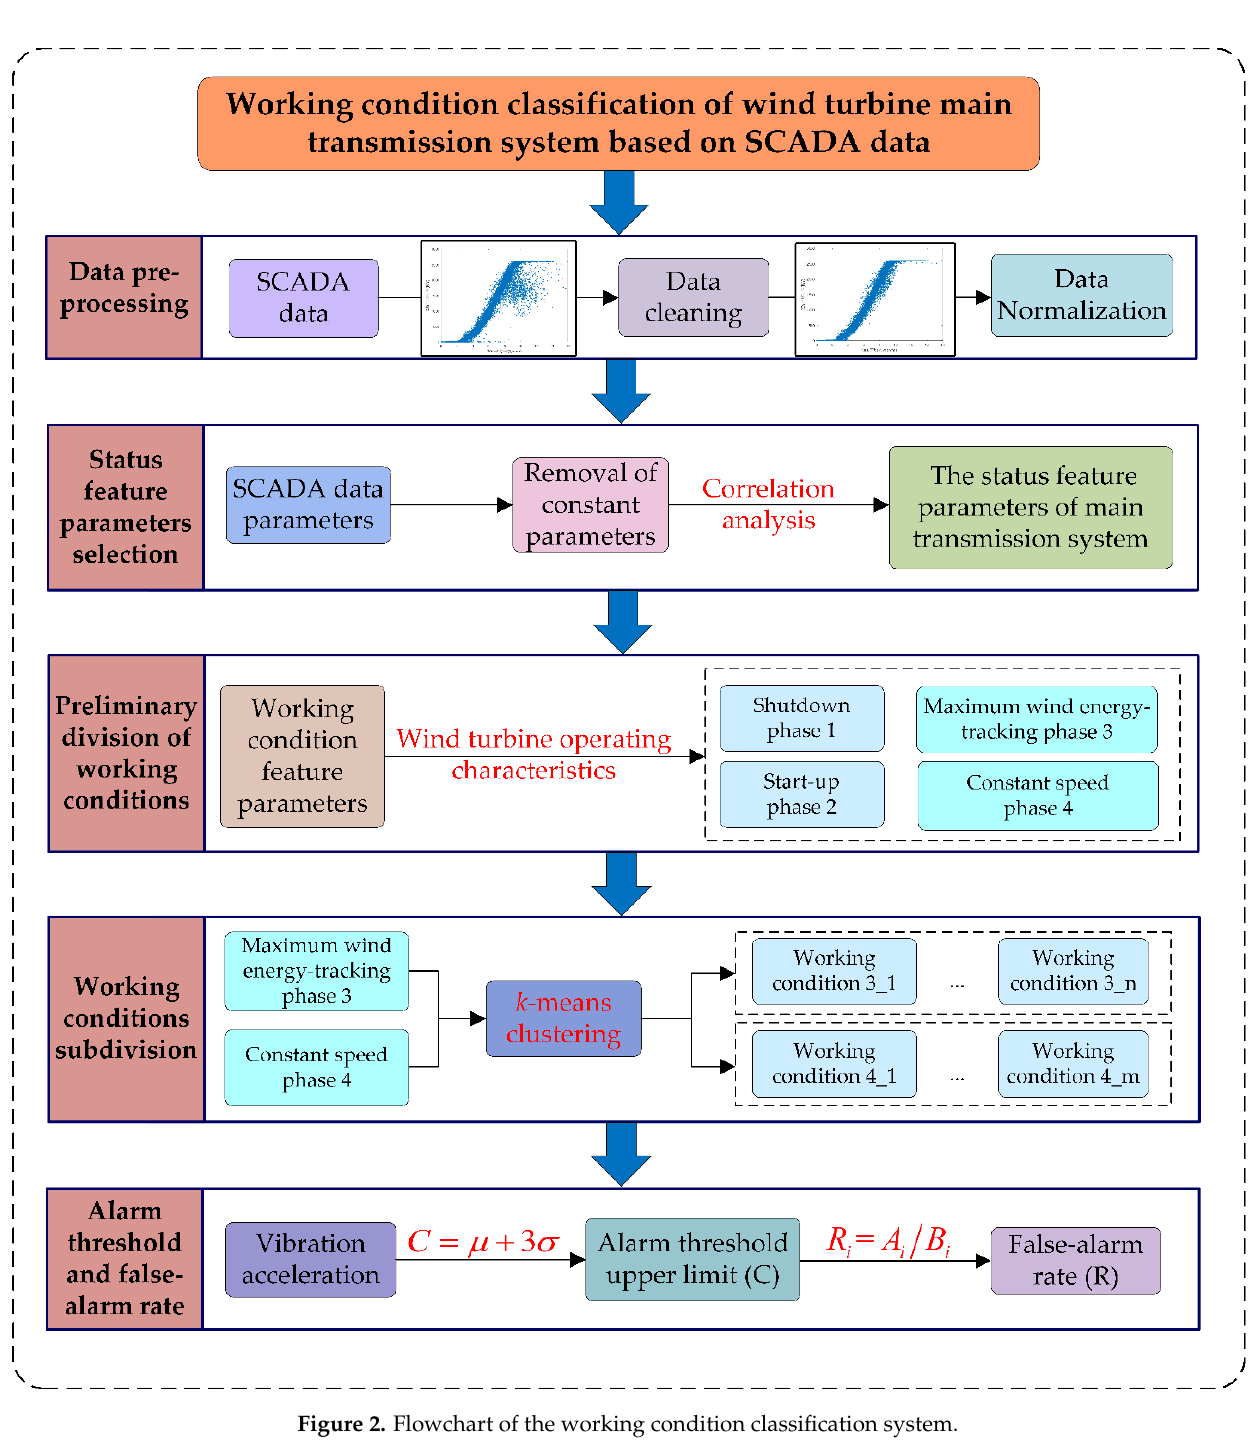
Figure 2. Flowchart of the working condition classification system.